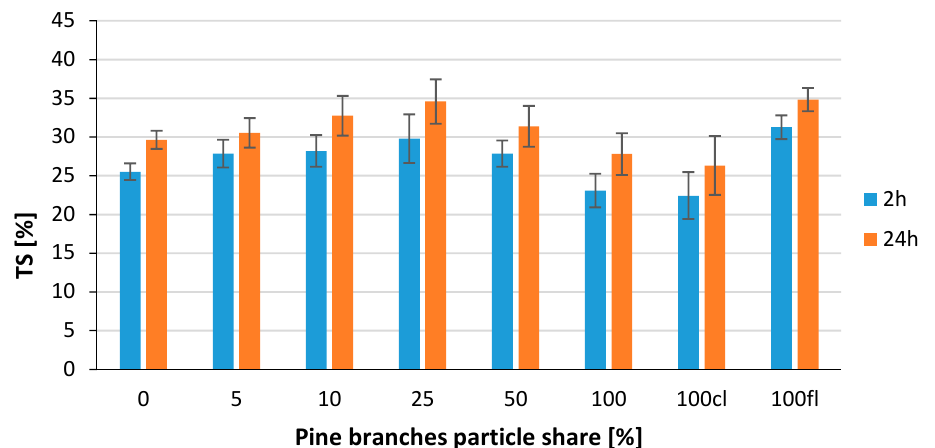
Figure 8. Thickness swelling of tested composites.